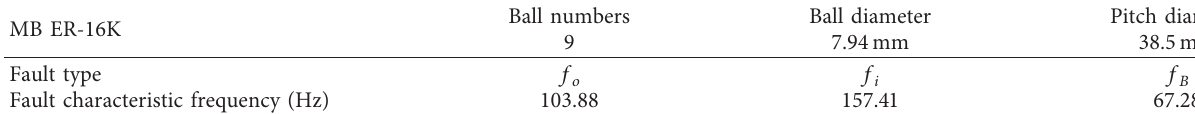
Figure 13: SpectrQuest machinery fault simulator test rig. Table 4: Geometry and characteristic frequencies of the rolling bearing.